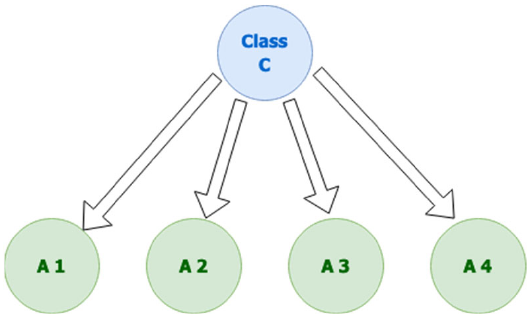
Figure 2. An example of Naïve Bayes .